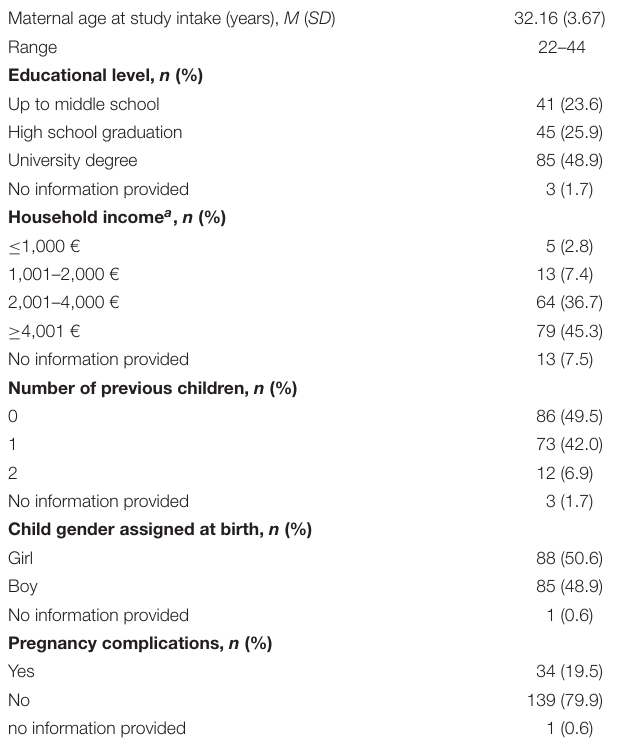
TABLE 1 | Characteristics of the